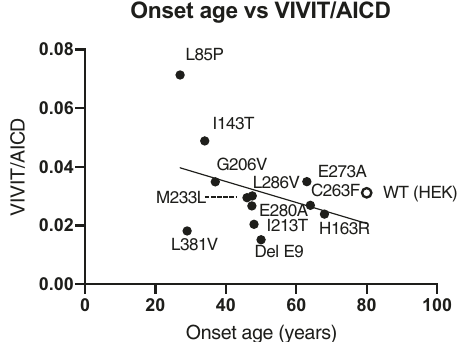
Fig. 5 FAD onset age versus the ratio of VIVIT/AICD. VIVIT was released from A β 48 to generate A β 43 by γ -secretase cleavage. The VIVIT/AICD ratio increased with onset age dependency. WT and mutant PS1 (L85P, I143T, H163R, L166P, G206V, I213T, M233T, C263F, E273A, E280A, L286V, G384A, and del E9) were used in this assay. The open circle indicates WT PS1, and the closed circles indicate FAD mutant PS1. ( n =